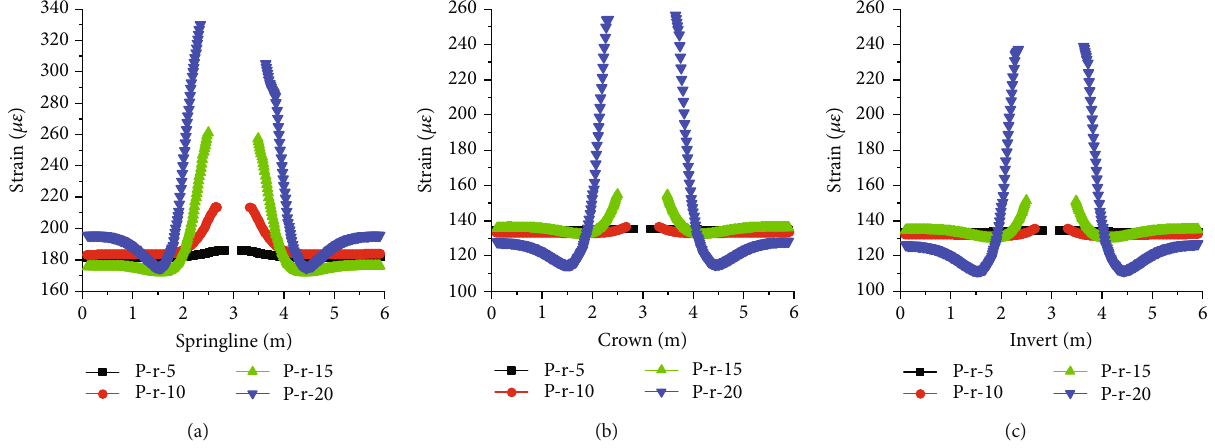
Figure 15: Strain of prestressing wires under combined loads: (a) springline; (b) crown; (c) invert.